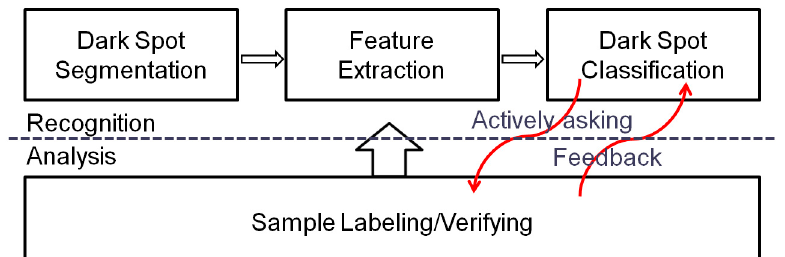
Figure 1. The role of active learning in the oil spill detection system. In conventional supervised classification system, the communication between the classification system (upper part) and the training sample collecting system (lower part) is one-way directed (as indicated by the big black arrow), where the collected samples are used to train the classifier with no feedback from the classifier on what kind of samples are most informative and urgently needed. However, in the active learning boosted system, the interaction between the two systems are bi-directional (as indicated by the red arrows), where the classifier will “ask for” the most relevant samples to be verified/labeled in order to learn the classifier in an efficient and effective manner. Considering the cost and difficulty in verifying the oil spill candidate, such an active learning process can greatly reduce the cost and time for building a detection system by reducing the number of candidates that needed to be verified without compromising the robustness and accuracy of the resulting classifier.